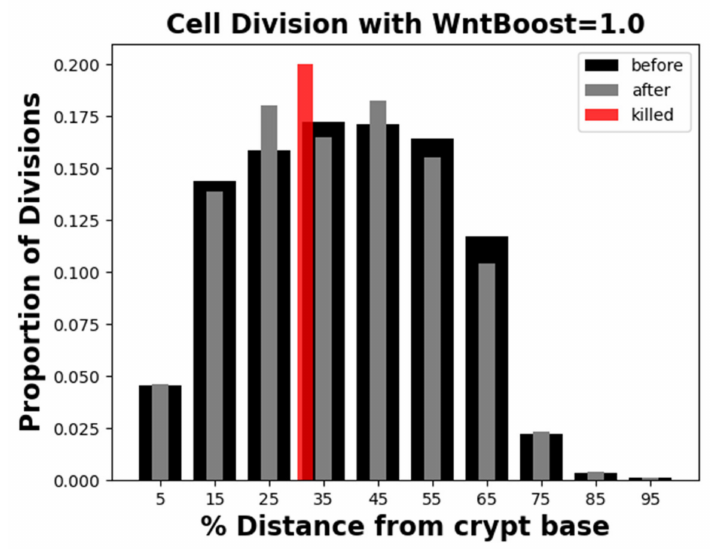
Figure A4. We employed the same CHASTE [40–42] model to probe whether a small local Wnt increase would result in globally visible proliferation changes. After ablation of a single cell in the crypt zone, the Wnt concentration of the neighboring cells was increased by 1.0. The simulation was run 10 times and averaged over the results. The percentage of cell division is plotted versus the distance from the crypt base. In black is the cell division before ablation and in gray after ablation. The averaged position of the ablated cell is shown in